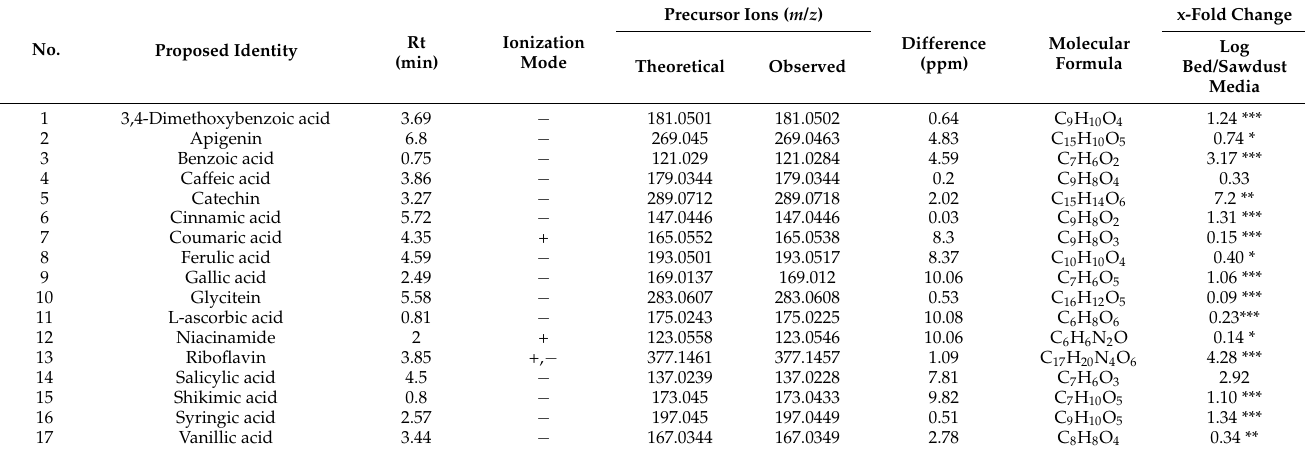
Table 2. Metabolites detected by UPLC-QTOF-MS in Lentinula edodes